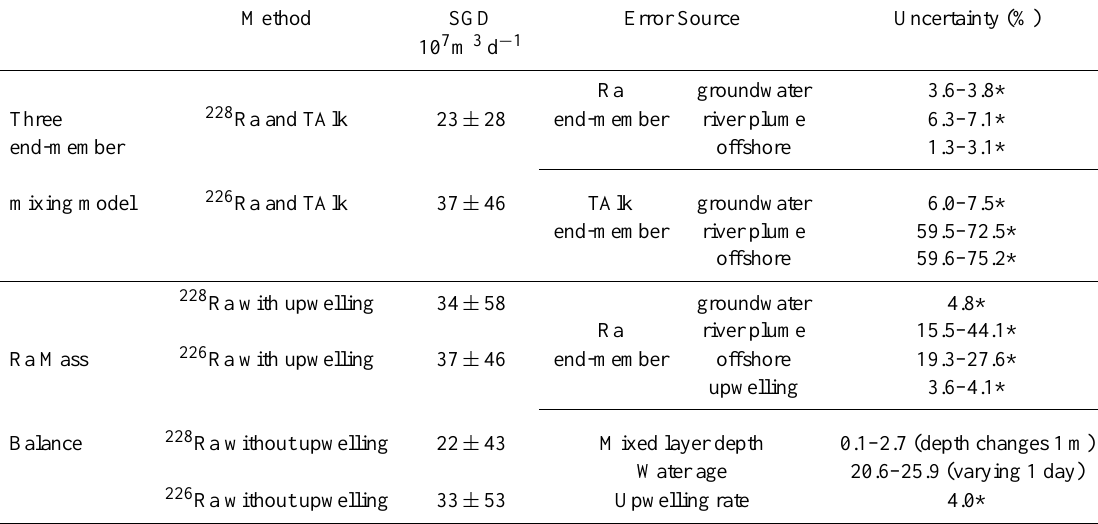
* represents 5% variation with each error